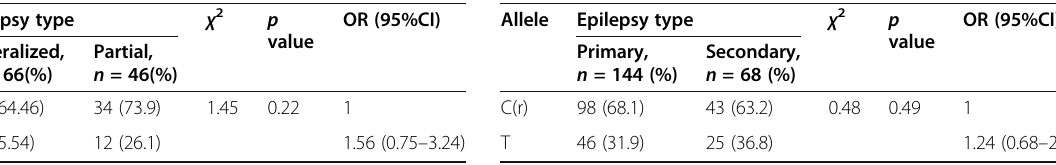
Table 5 Association between MDR1 C3435T allele and epilepsy types (generalized and partial)